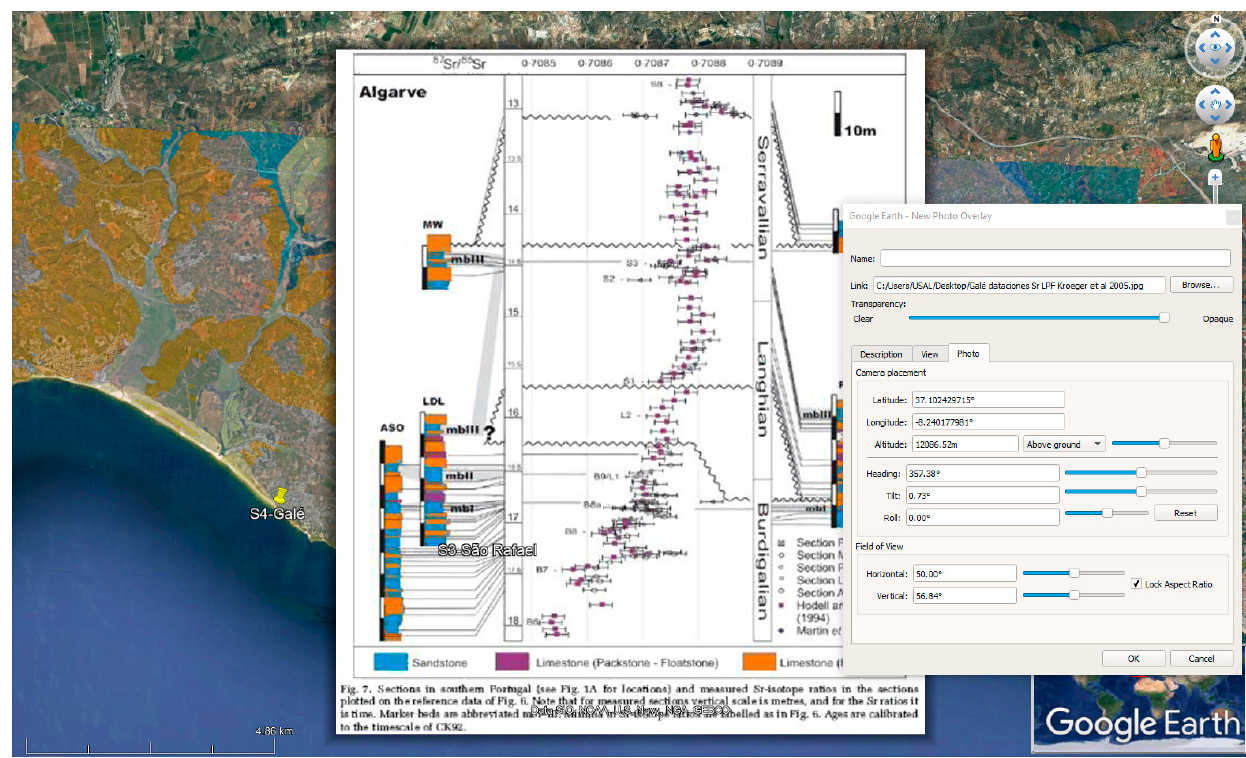
Figure 4. Capture of the Google Earth script that shows the location of the different images on the 3D virtual globe displayed from any mobile application. The pop-up window shows the commands and possibilities of movement that Google Earth offers. Left window [27].